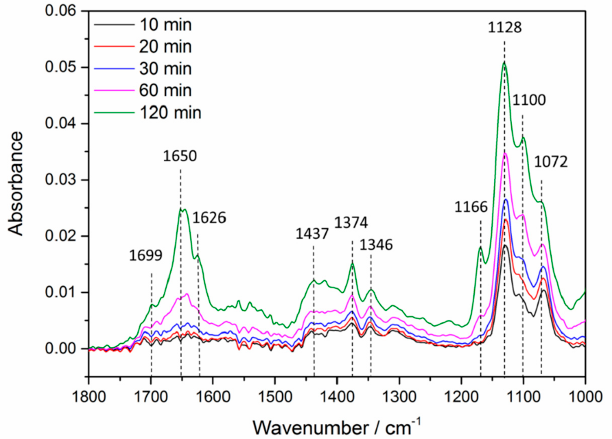
Figure 3. ATR-FTIR spectra recorded during the gaseous treatment of acetaldehyde in air over a TiO 2 film, for 2 h, under dry conditions, in the dark. Table 1. Vibrational frequencies and mode assignments of the observed FTIR bands (cm − 1 ) during purging of acetaldehyde in air, over a TiO 2 film in the